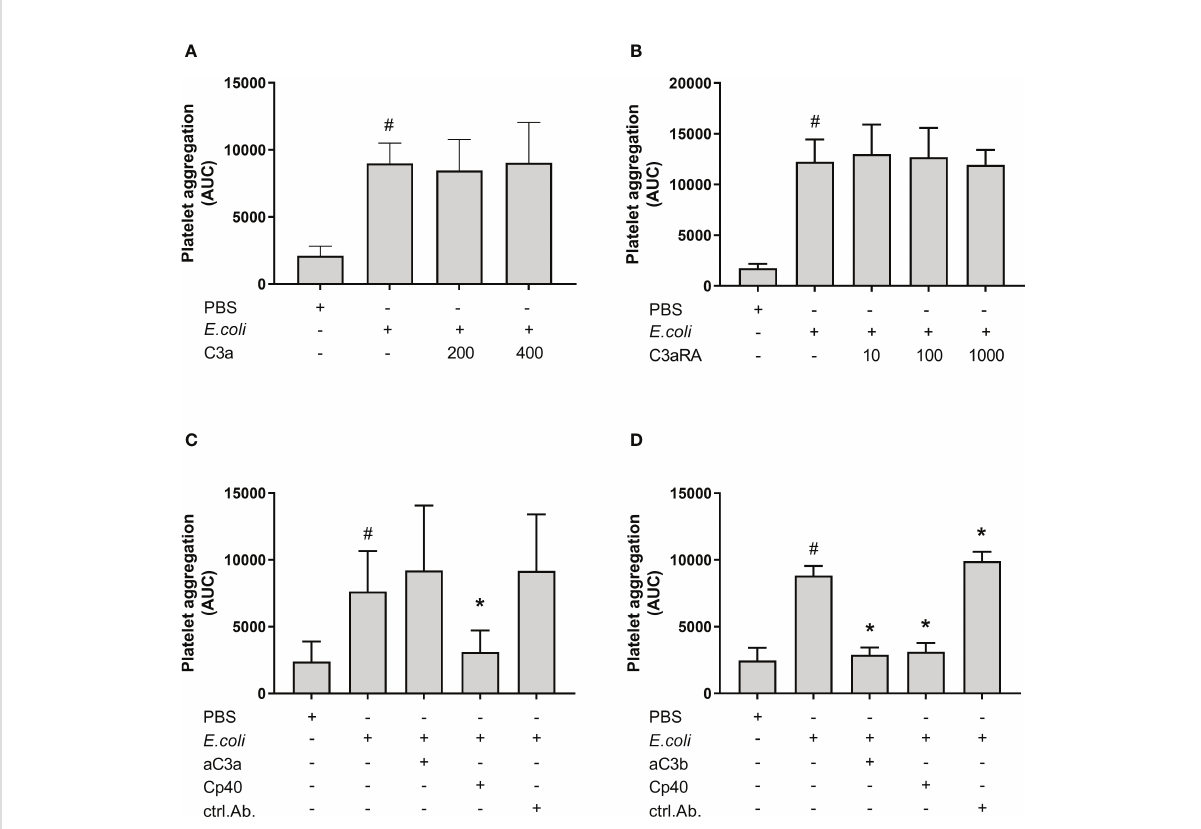
FIGURE 2 The effect of C3a and C3b (C3a, C3a receptor antagonist (RA), anti-human C3a antibody and blocking anti-human C3b antibody) on Escherichia coli ( E. coli 5.3 x 10 9 /mL)-induced platelet aggregation measured by Multiplate ® impedance aggregometry. To the samples were added phosphate-buffered saline (PBS) control or puri fi ed C3a in increasing concentrations (200 nM and 400 nM) (n = 5) (A) . To the samples were added PBS control or C3aRA in increasing concentrations (10 nM, 100 nM and 1000 nM) (n = 4) (B) . To the samples were added PBS control, C3a antibody (aC3a, 0.2 g/mL), compstatin (Cp40, 20 µM) or control antibody (ctrl.Ab, 0.2 mg/mL) (n = 5) (C) . To the samples were added PBS control, C3b antibody (aC3b 0.2 mg/mL), compstatin (Cp40, 20 µM) or control antibody (ctrl.Ab 0.2 mg/mL) (n = 3) (D) . To all samples, PBS or E. coli were added as activators. Results are given as the area under the curve (AUC), using mean ± standard deviation. #; p < 0.05 analyzed using a paired Student ’ s t-test between the samples with and without E. coli , *; p < 0.05 analyzed using one-way ANOVA repeated measurements, and Dunnett ’ s multiple comparisons test, comparing E. coli -activated samples with and without inhibitors or